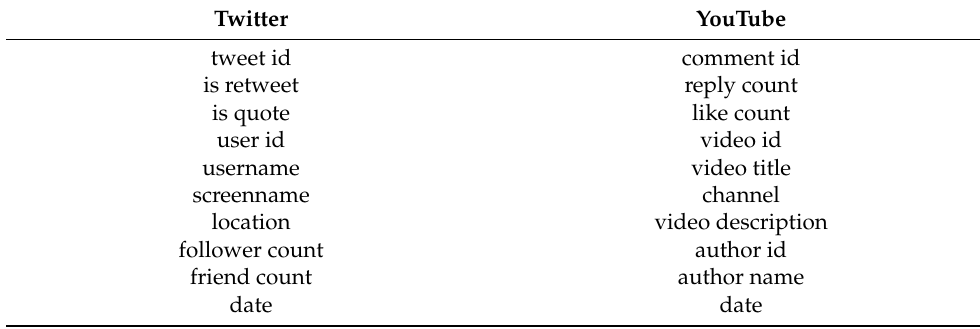
Table 2. The metadata fields that are exploited for the YouTube and Twitter